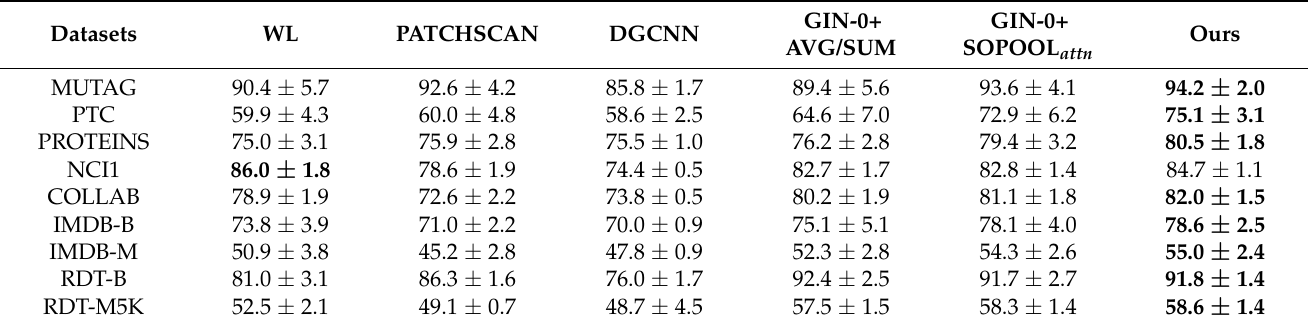
Table 3. Graph classification accuracy (%). The best result is marked with boldface.